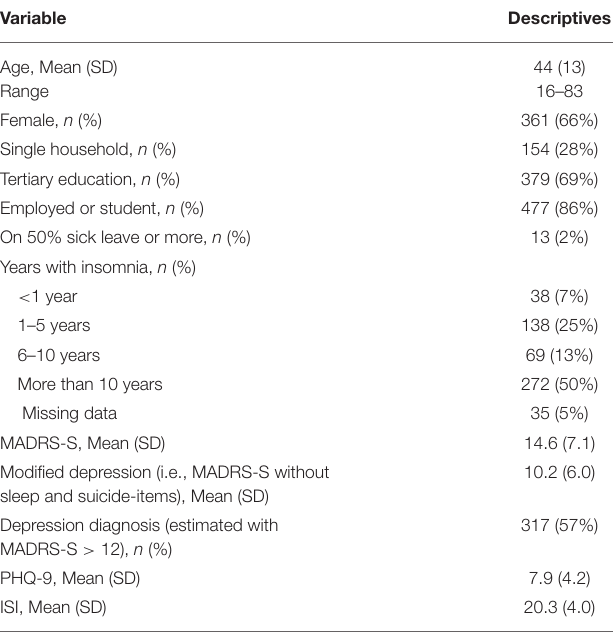
TABLE 2 | Demographics and pretreatment symptom levels for all participants ( n = 552).